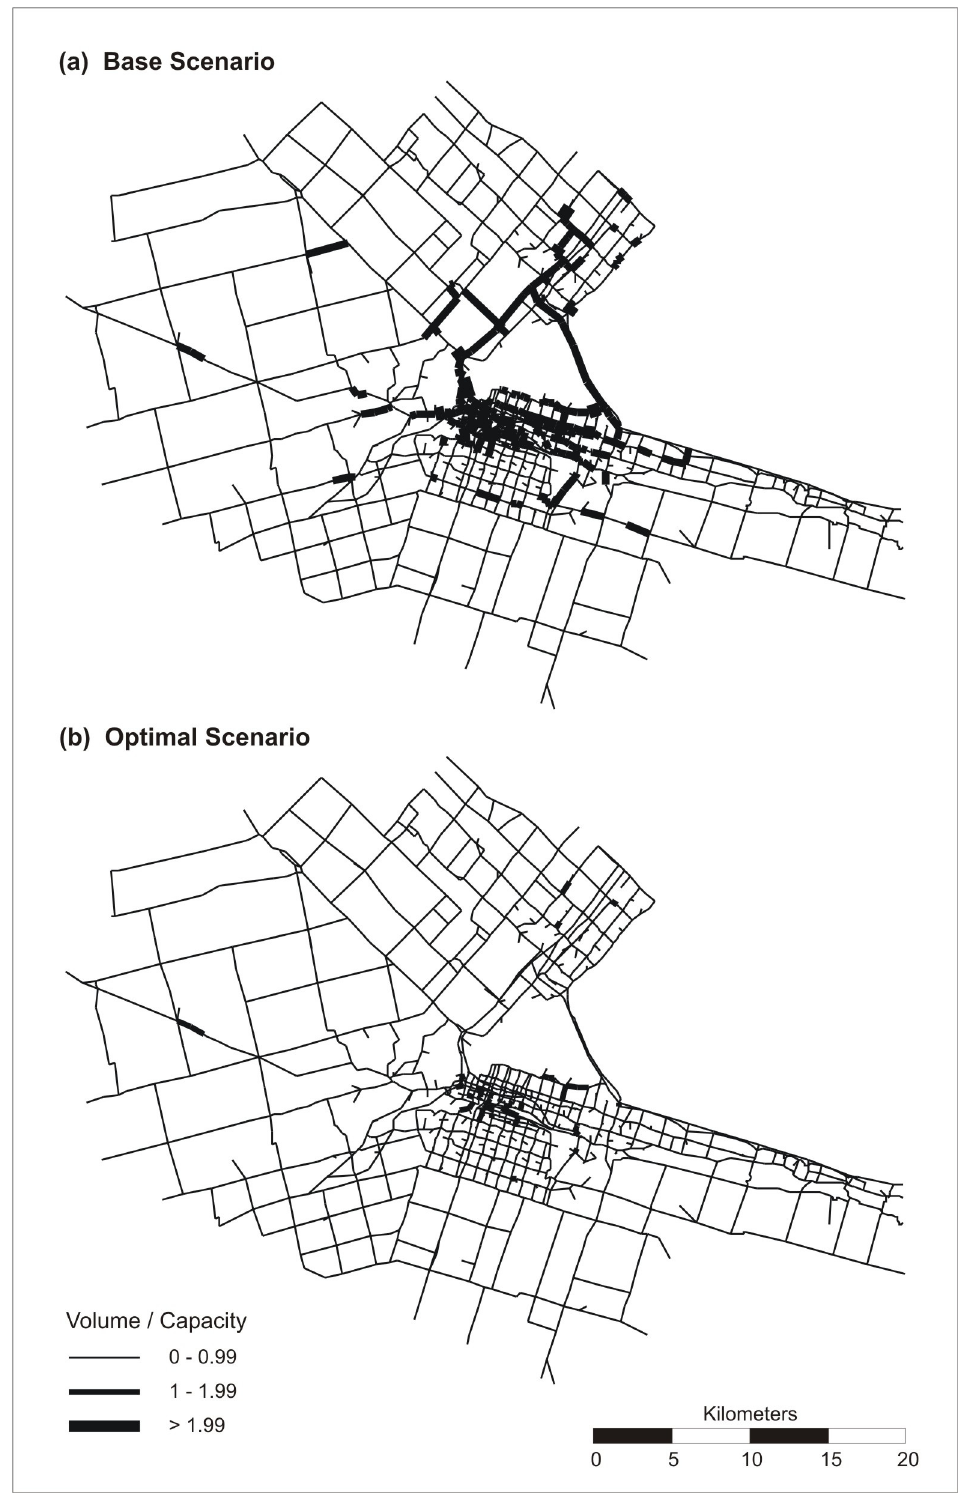
Figure 3. Congestion in the Hamilton CMA (Scott et al.